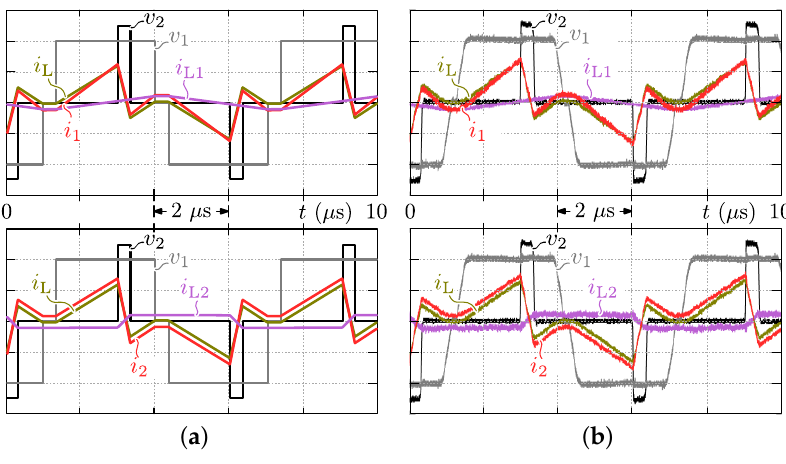
Figure 27. ( a ) Calculated and ( b ) measured HF ac-link currents and voltages at v dc,1 = 50 V, (cid:104) i dc,1 (cid:105) = 3.05 A, V dc,2 = 370 V, where τ 1 = 2.77 rad., τ 2 = 0.35 rad., φ = − 0.7 rad., f s = 83.1 kHz (mode 1